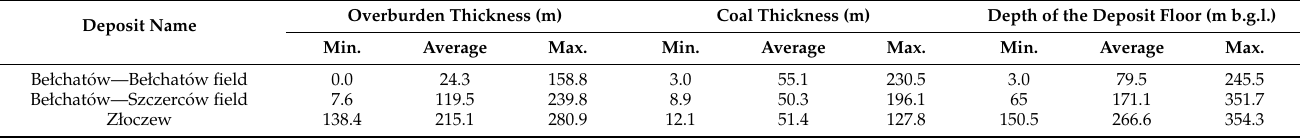
Table 1. Parameters of the geological location of the coal seam(s) in individual